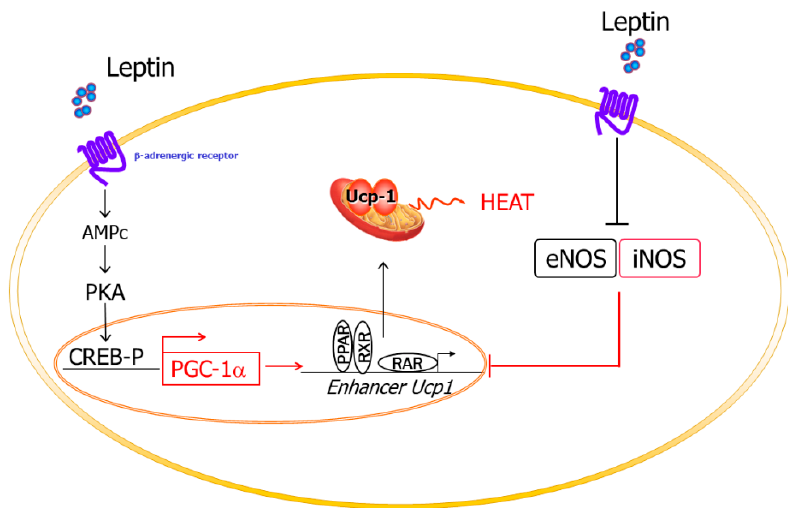
Figure 2. Leptin and NO participation in energy expenditure. Leptin increases energy expenditure by increasing UCP expression and through decreased NO production, which, in turn, activates the expression of UCP. NO, nitric oxide; UCP: uncoupling protein.